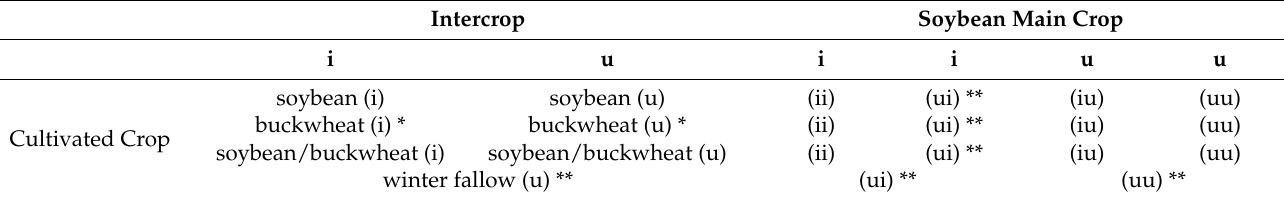
Table 3. Overview of the individual test